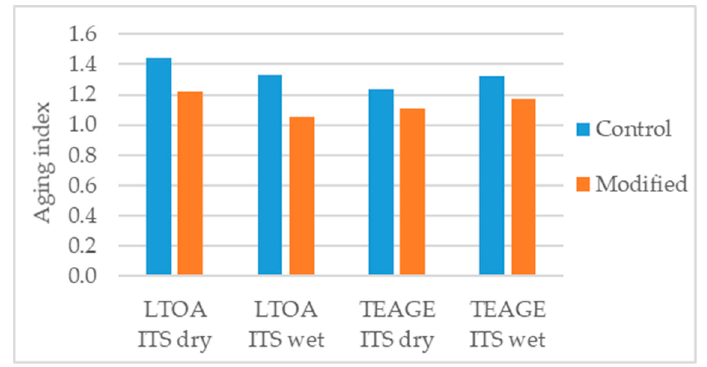
Figure 19. Aging index of the parameters considered in the study [100].